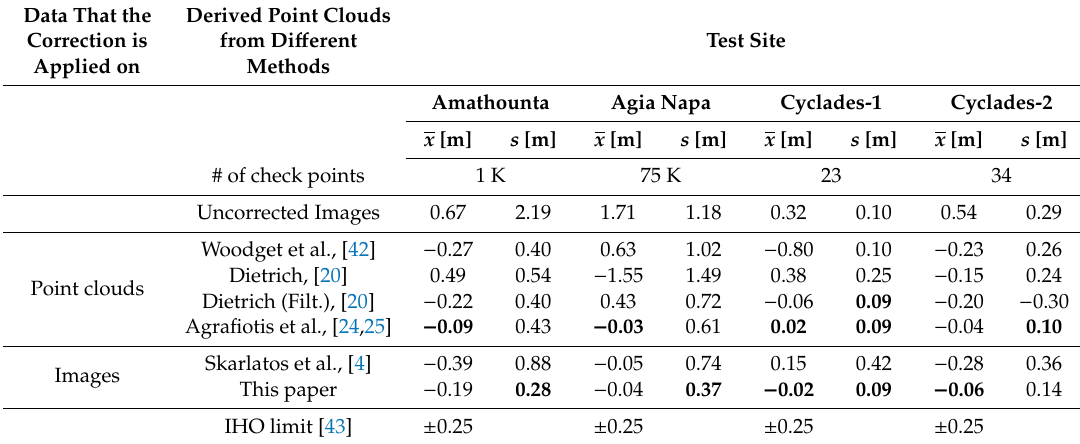
Table 3. Quantitative evaluation. x is the average distance of the point cloud from the ground truth, and s its standard deviation. Negative values suggest overestimation of the depth, and positive values suggest underestimation. The best results for each test site are in